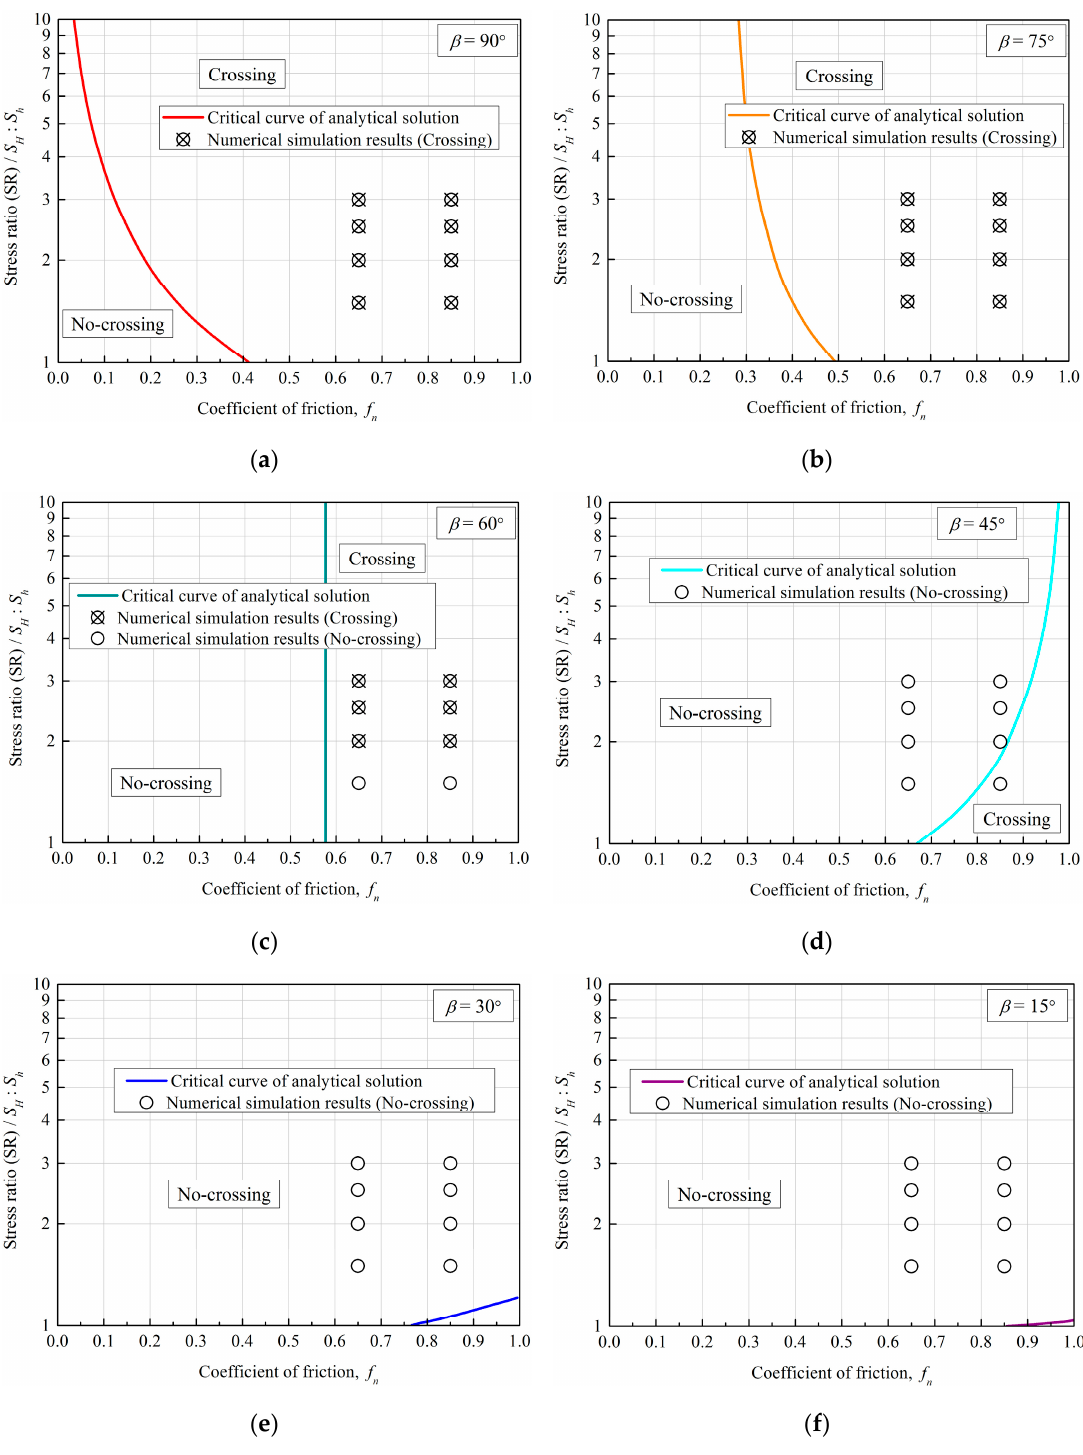
Figure 9. Comparison results between numerical simulations and analytical solutions [20]: ( a ) β = 90°; ( b ) β = 75°; ( c ) β = 60°; ( d ) β = 45°; ( e ) β = 30°; and ( f ) β = 15°.